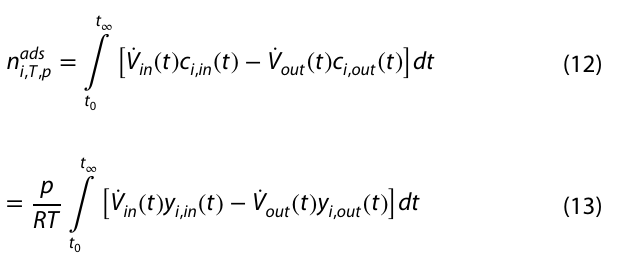
imposed onto a sample of Ni-MOF-74@ 2